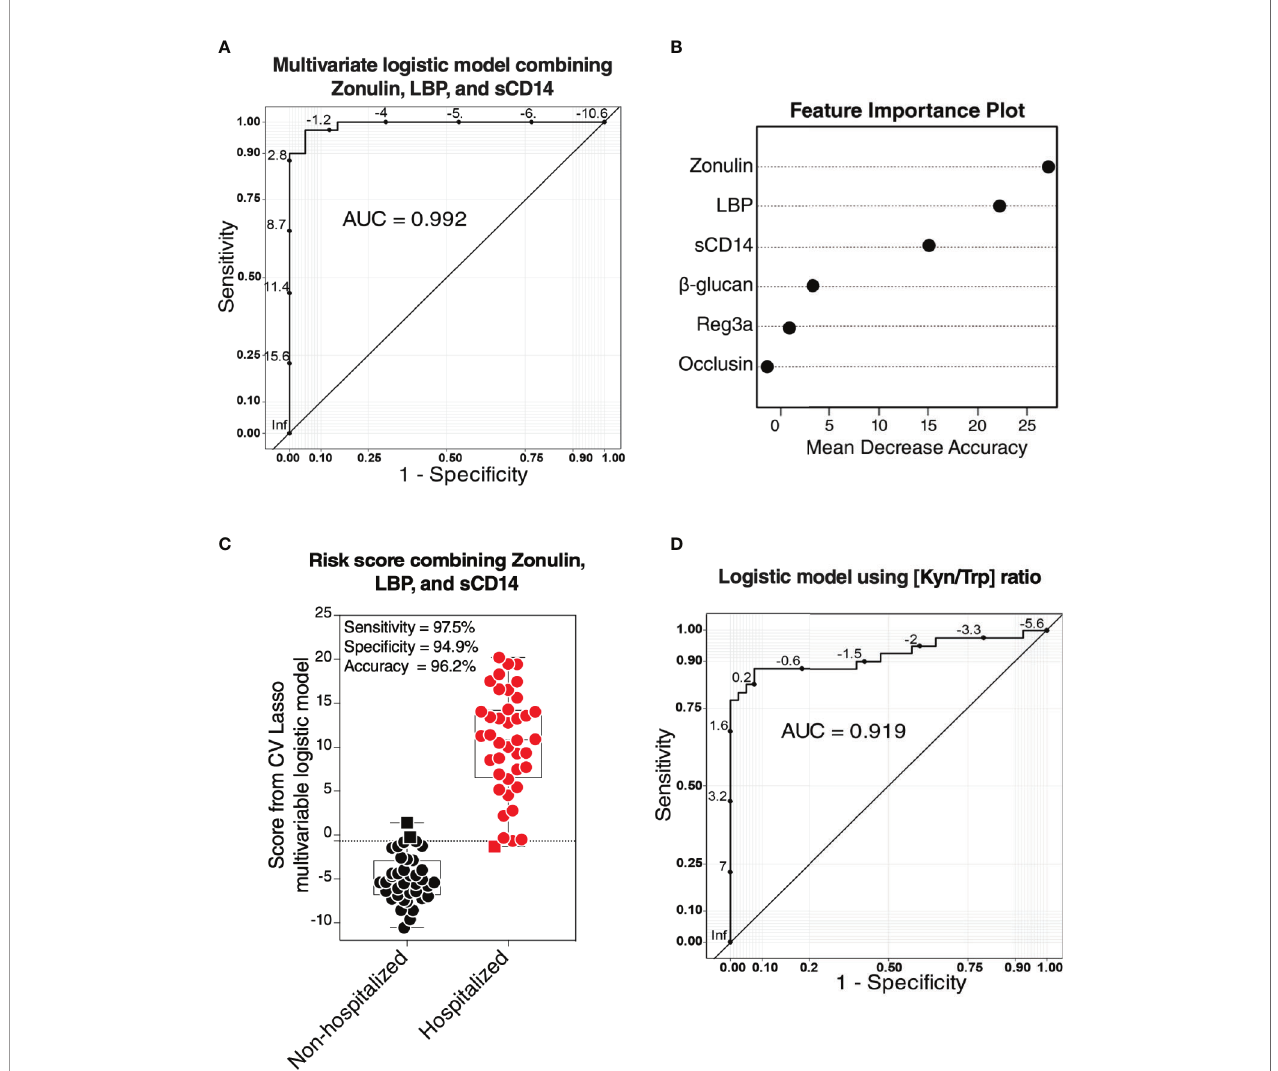
FIGURE 7 | Logistic models using markers of tight-junction permeability and microbial translocation distinguish hospitalized from non-hospitalized individuals. (A, B) The machine learning algorithm, Lasso (least absolute shrinkage and selection operator) regularization, selected three markers (zonulin, LBP, and sCD14) that, when combined, can distinguish hospitalized from non-hospitalized individuals. (A) The receiver operator characteristic (ROC) curve from the multivariable logistic regression model with the three variables combined. (B) feature importance plot. (C) Coef fi cients from the multivariable logistic model were used to estimate a hospitalization risk score for each individual and then tested for the ability of these scores to accurately classify hospitalized (n=40) from non-hospitalized (n=39; one sample did not have a complete dataset) individuals at an optimal cut-point. Squares represent individuals the model failed to identify correctly. (D) Logistic regression model using the L-kynurenine/L-tryptophan [Kyn/Trp] ratio is able to distinguish hospitalized from non-hospitalized individuals. ROC curve showing the area under the curve (AUC) is